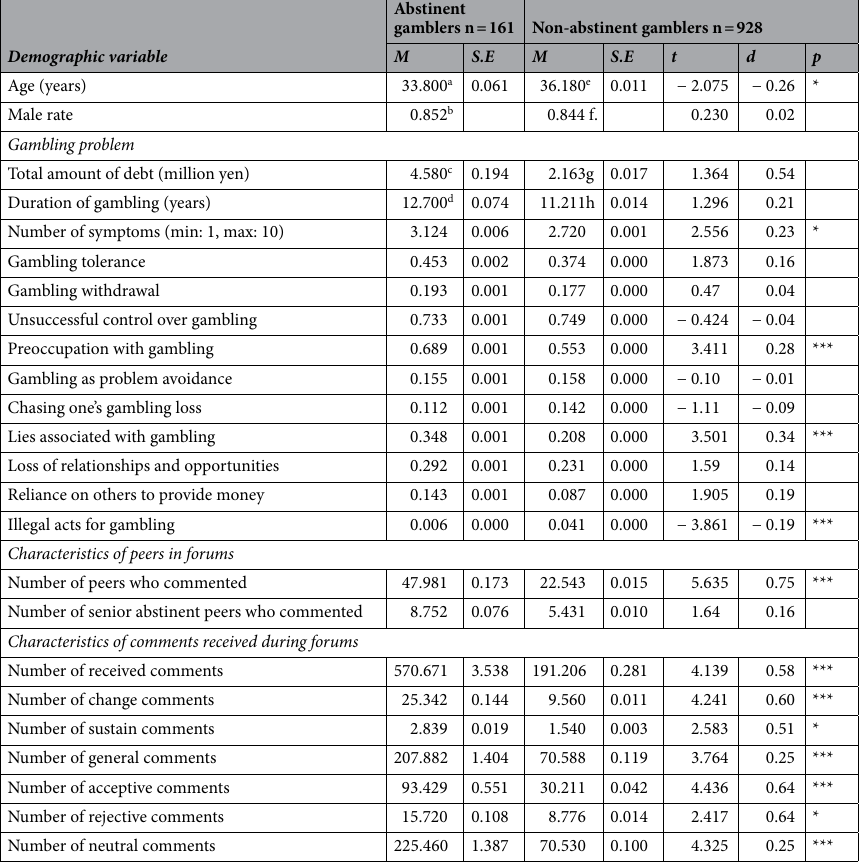
Table 1. Differences in demographic variables, gambling problems, peers, and received comments between abstinent and non-abstinent gamblers in the first 3 years of attending the online self-help forums to quit gambling. The data sizes of the demographic variables and gambling histories were smaller than those of the comments. S.E: Standard Error , a n = 75, b n = 115, c n = 19, d n = 50, e n = 428, f n = 634, g n = 107, h n = 251. One million yen was approximately US$ 9193.* p < 0.05, ** p < 0.01, *** p <